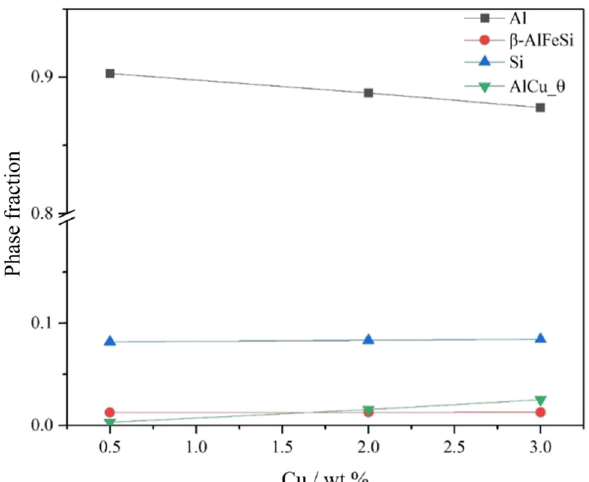
Figure 13: Phase fraction of alloy with di ff erent Cu contents after solidi fi